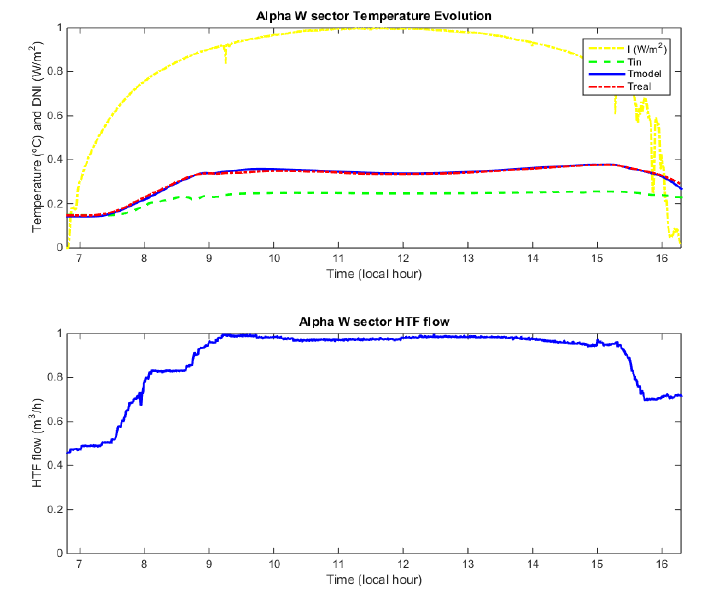
Figure 8. Alpha West sector, model vs. real evolution: ( top ) model (blue solid) and real (red dash-dotted); and ( bottom ) HTF flow.